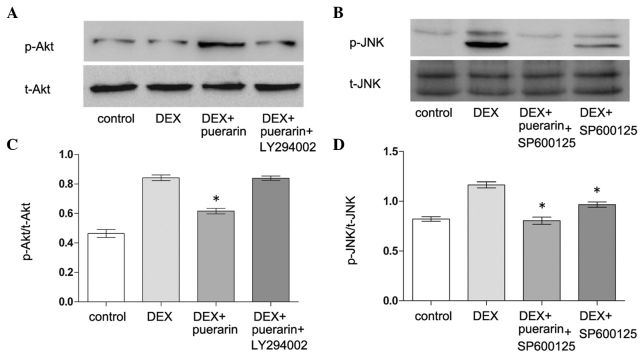
Effects of LY294002 and SP600125 on the expression levels of p-Akt and p-JNK in hFOB1.19 cells. (A) Cells were treated with DEX (10−5 M), DEX (10−5 M) + LY294002 (10−5 M), or DEX (10−5 M) + puerarin (10−8 M) + LY294002 (10−5 M). Expression levels of p-Akt and t-Akt were detected using western blot analysis. (B) Cells were treated with DEX (10−5 M), DEX (10−5 M) + SP600125 (10−5 M), or DEX (10−5 M) + puerarin (10−8 M) + SP600125 (10−5 M). Expression levels of p-JNK and t-JNK were detected using western blot analysis. Data are presented as the mean ± standard deviation. *P<0.05, vs. DEX. JNK, c-Jun N-terminal kinase; p-, phosphorylated; t-, total.